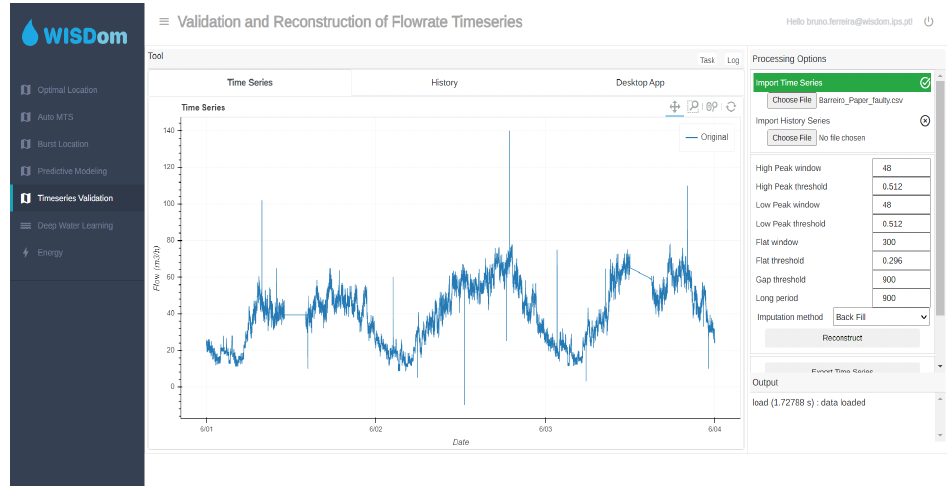
Figure 3. Screenshot of tool for the flow rate time series processing.